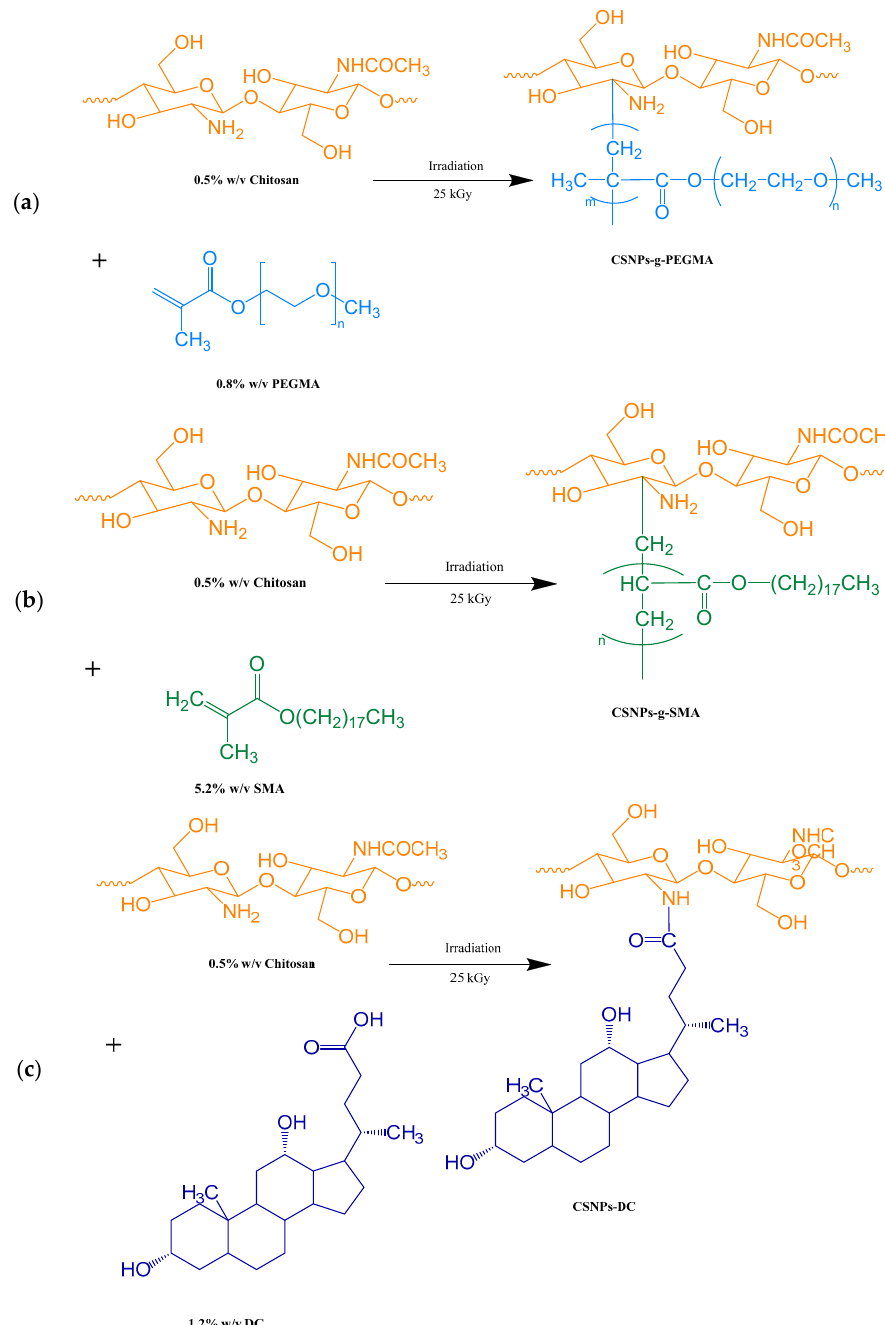
Figure 11. Modification reaction of CSNPs for preparing the different derivatives: ( a ) CSNPs-g-